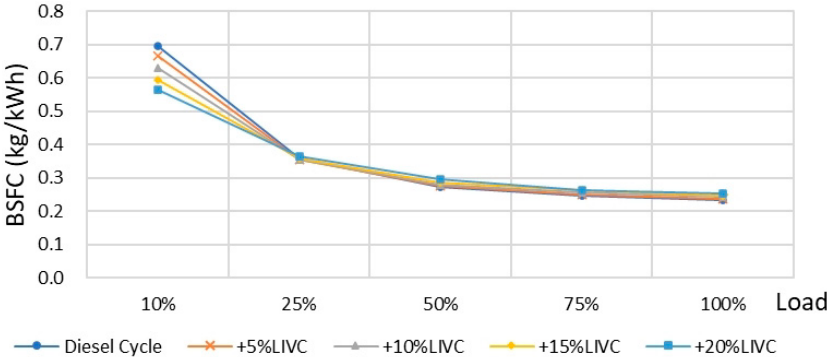
Figure 8. Comparison of BTEE under diesel engine LIVC Miller cycle.